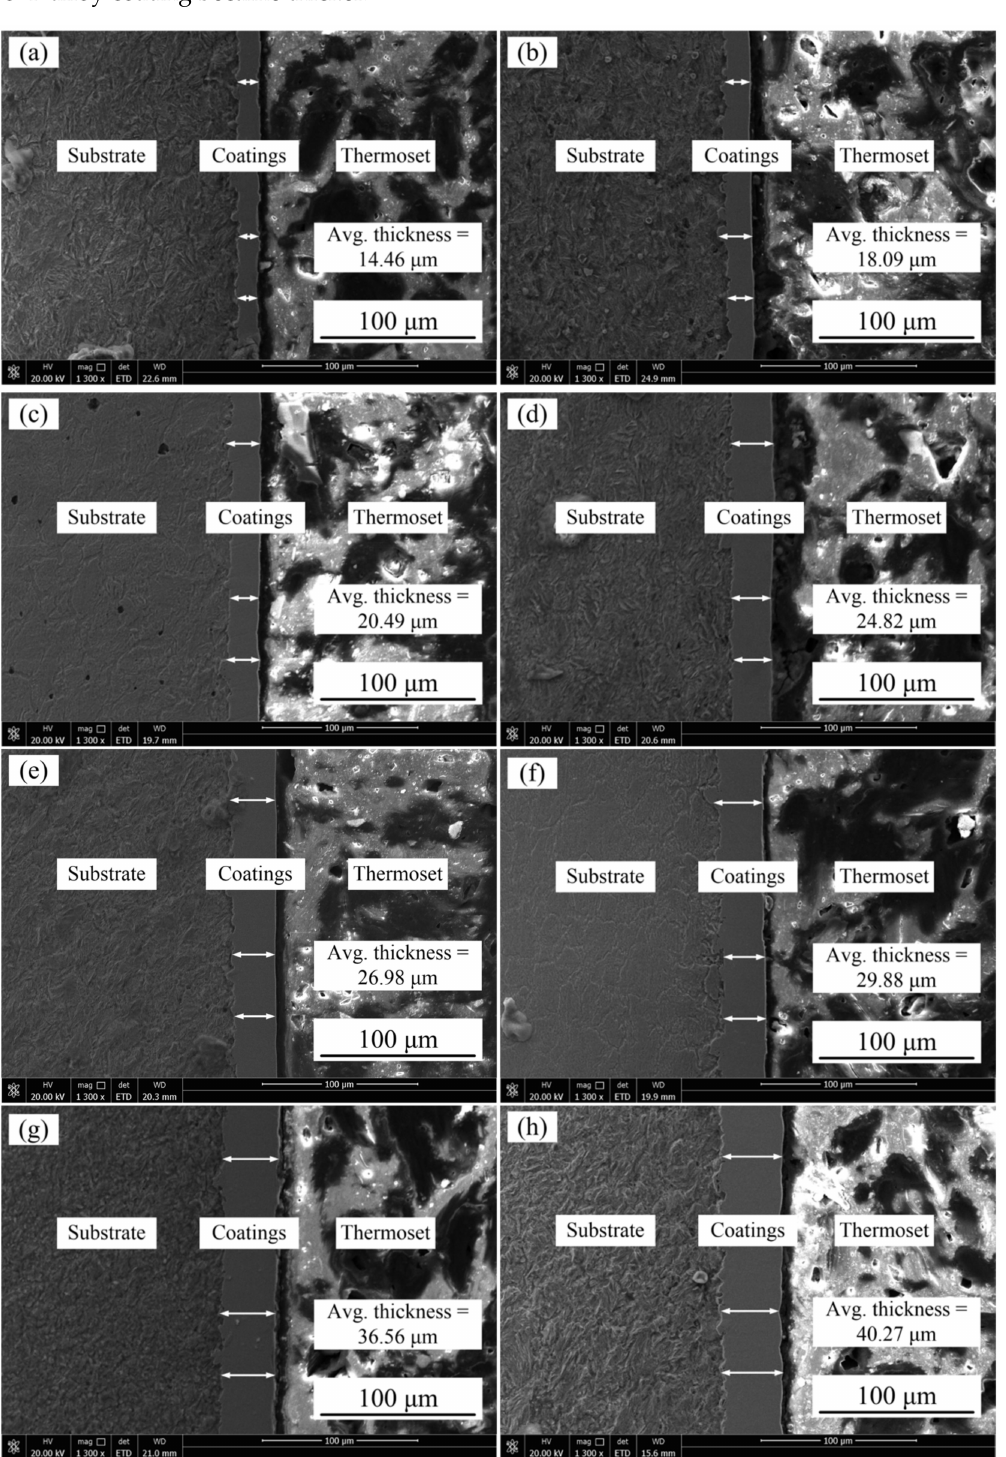
Figure 3. E ff ect of the temperature of plating solution on cross section morphologies of Ni–Co–P alloy coatings: ( a ) 40 ◦ C; ( b ) 45 ◦ C; ( c ) 50 ◦ C; ( d ) 55 ◦ C; ( e ) 60 ◦ C; ( f ) 65 ◦ C; ( g ) 70 ◦ C; and ( h ) 75 ◦